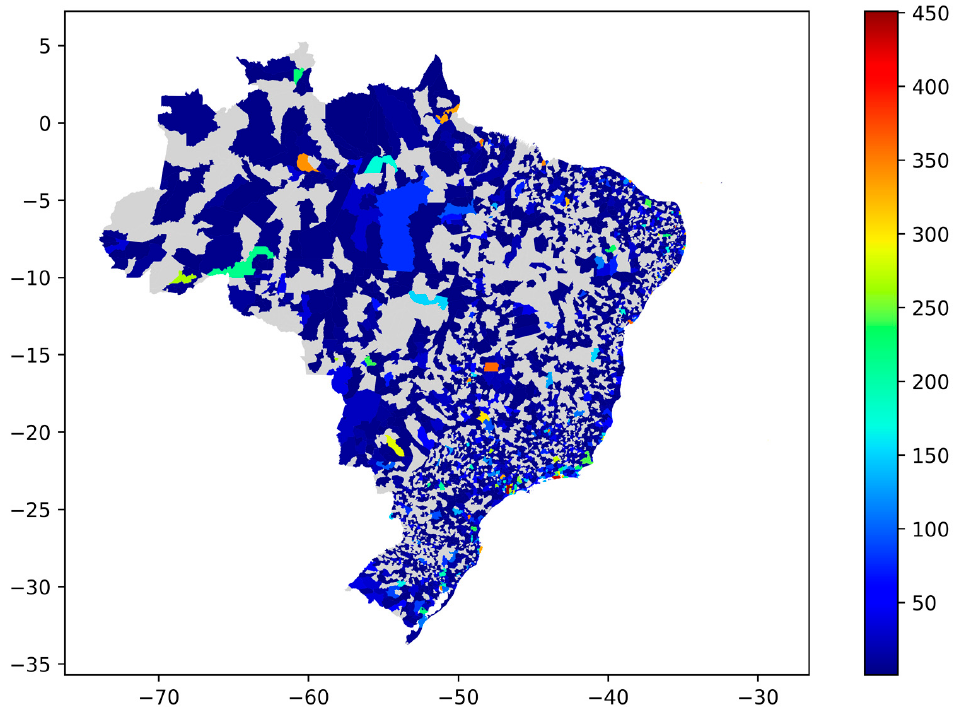
Figure 3. Overall tweets distribution in Brazilian territory.